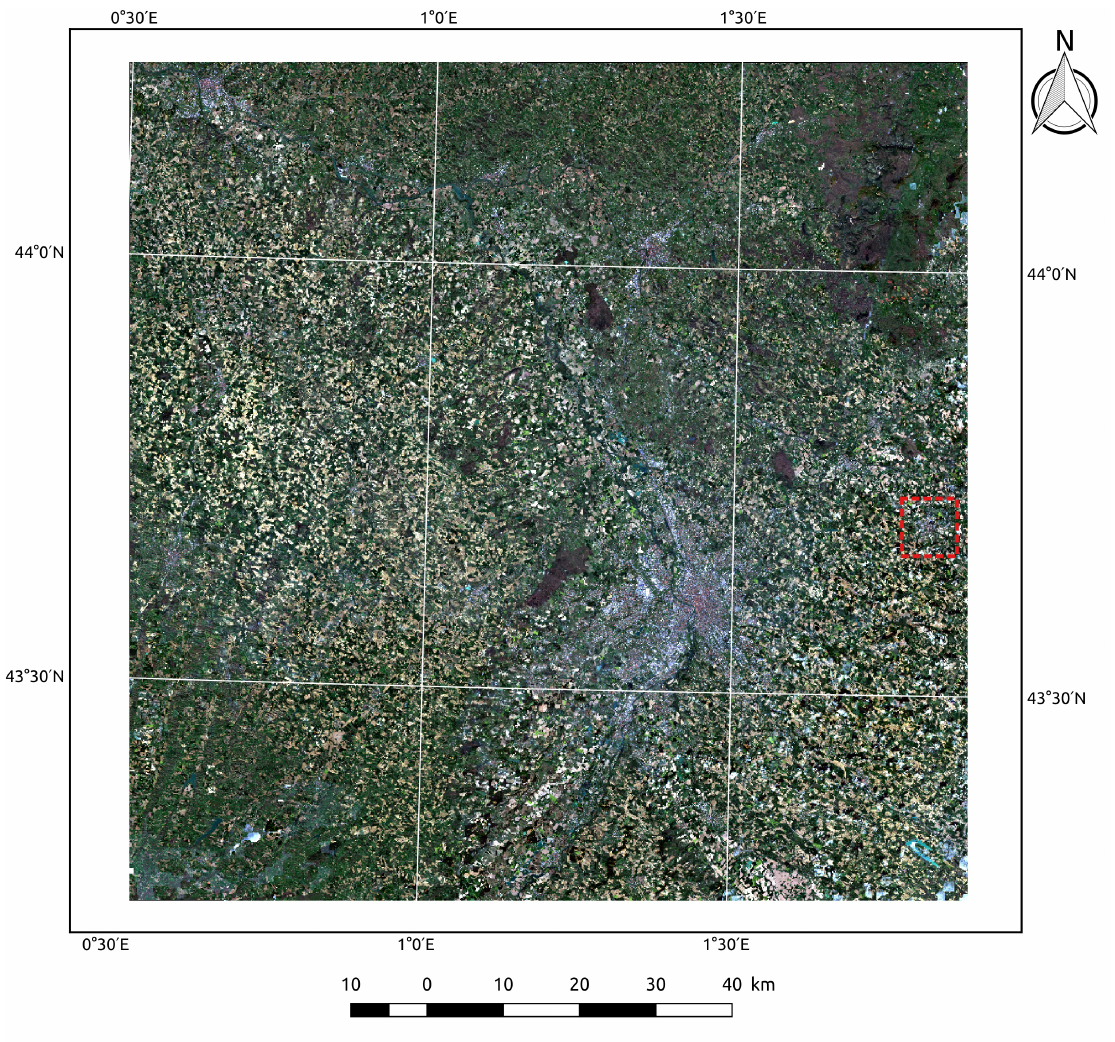
Figure 12. The area chosen for the detailed experiments is 110 × 110 km tile containing the city of Toulouse in the lower right side of the image (T31TCJ in Figure 11). The image shows RGB bands of the first date of the Sentinel-2 time series. The red dotted line represents the extent of the region shown in Figures 9, 10 and